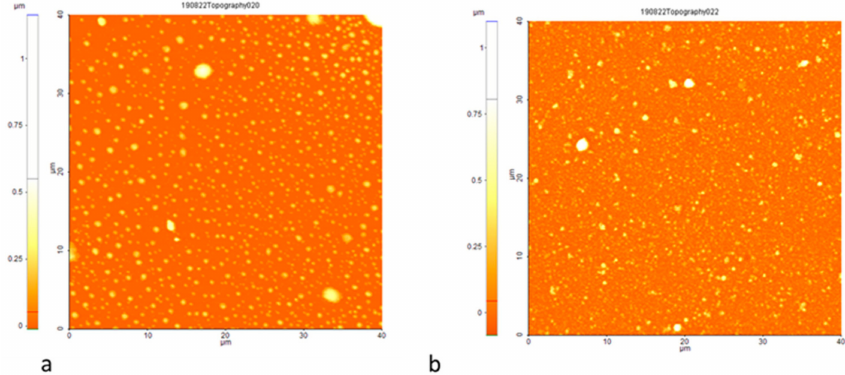
Figure 6. AFM image of the AChE enzyme on the S2 ( a ) and S3 ( b ) sensor surface over large surfaces (40 µ m × 40 µ